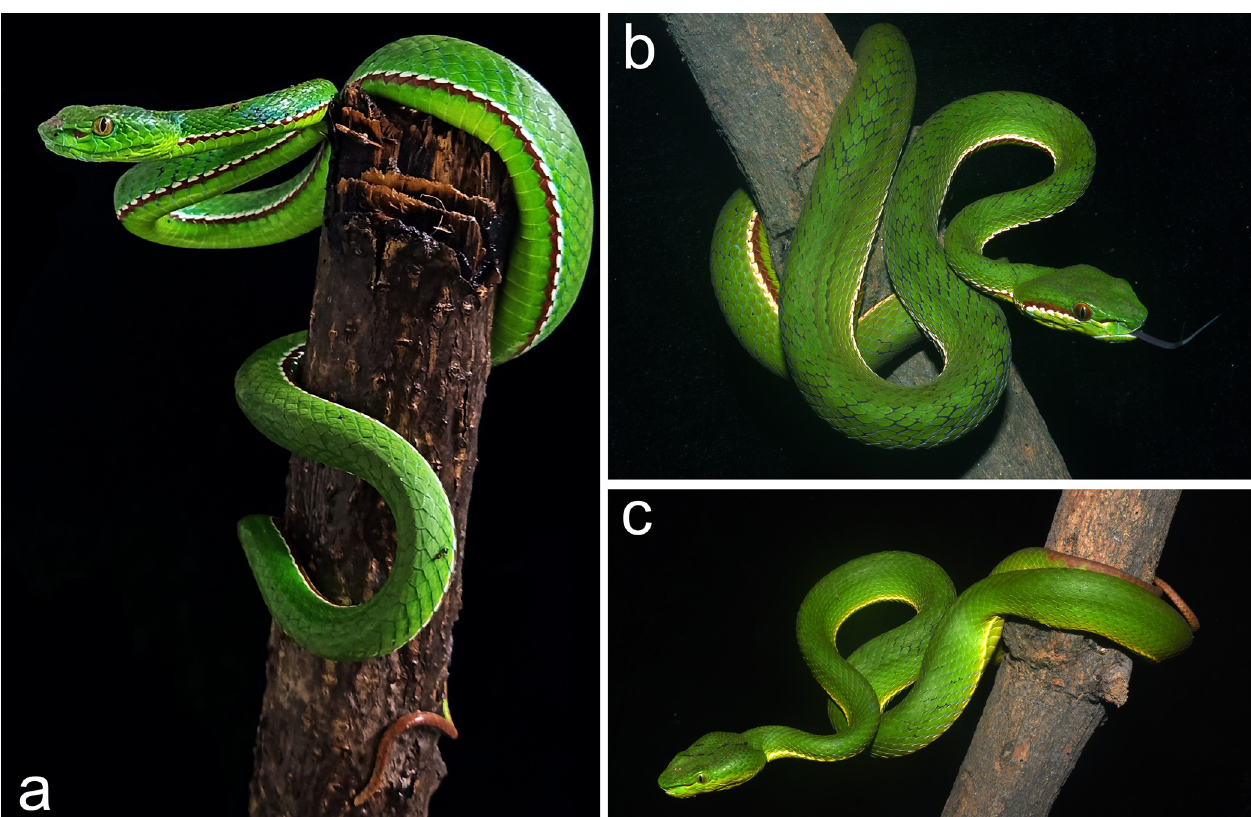
Fig 6. Trimeresurus mayaae sp. nov. in life (a) holotype male NCBS NRC-AA-0012, Photo Hmar Tlawmte Lalremsanga, (b) uncollected male photo by Hmar Tlawmte Lalremsanga, (c) uncollected female photo by Jayaditya Purkayastha. vogeli and golden yellow in T . yunnanensis . A bicoloured (broad red above and thin white below) postocular streak is present in males of Trimeresurus mayaae sp. nov. versus white in T . stejnegeri , white, thin and faint in T . vogeli , no postocular streak in T . yunnanensis . A white ventrolateral stripe is present in female Trimeresurus mayaae sp. nov. versus red + white in T . medoensis and pale green in T . yunnanensis . Trimeresurus mayaae sp. nov. has 19–21 dorsal scale rows at the midbody versus 17 in T . medoensis and 19 in T . yunnanensis . Trimeresurus mayaae sp. nov. with 3–4 palatine teeth versus 5 in T . yunnanensis ; Trimeresurus mayaae sp. nov. with 10 pterygoid teeth versus 12–14 in T . yunnanensis & T . stejnegeri . The new species differs from members of Viridovipera in showing a pairwise sequence divergence (p-distance) of 5–10% for cytochrome b gene (S1 Table).